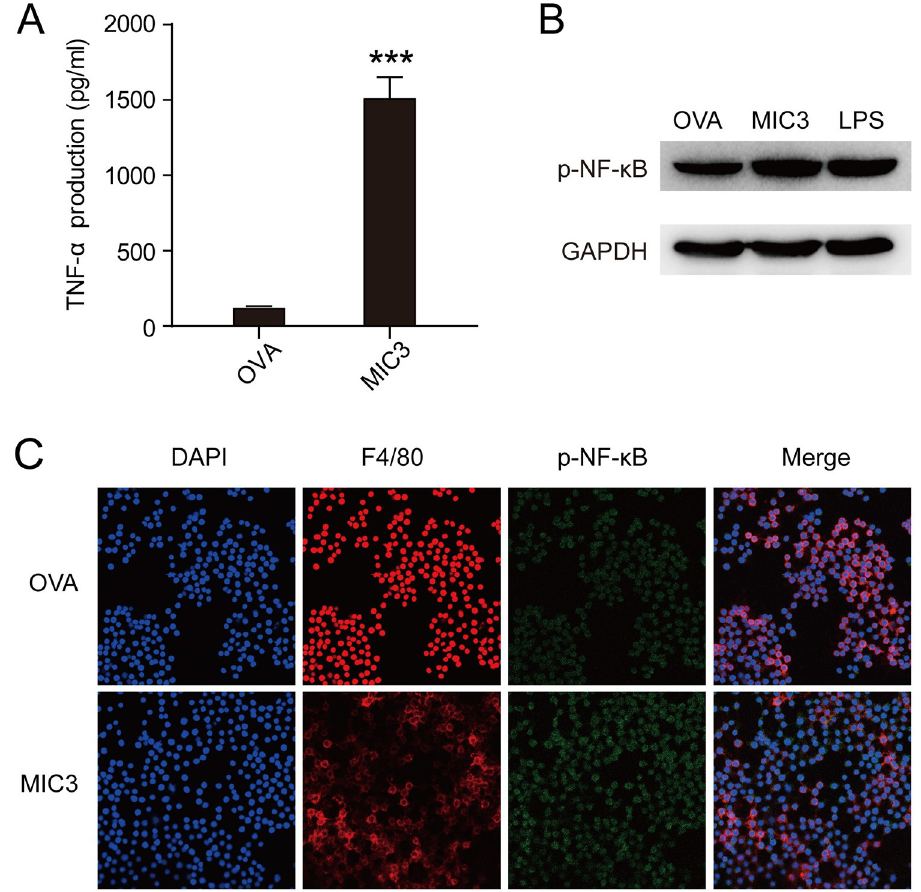
Fig 1. MIC3 induced TNF- α expression and NF- κ B p65 phosphorylation in RAW264.7 cells. (A) The levels of TNF- α secreted by RAW264.7 cells after 24 h-treatment of 4 μ g/ml MIC3 and OVA. Data are expressed as the means ± S.D. of four independent samples for each group. Significance was determined by the two-tailed Student’s t - test. ��� , P < 0.001. (B) NF- κ B p65 phosphorylation of macrophages after the treatment of MIC3. The NF- κ B p65 phosphorylation of RAW264.7 cells after 24 h-treatment of 4 μ g/ml MIC3, 4 μ g/ml OVA and 1 μ g/ml LPS was detected by Western blotting. (C) The NF- κ B p65 phosphorylation of RAW264.7 cells after 24 h-treatment of 4 μ g/ml MIC3 and 4 μ g/ml OVA was evaluated by immunofluorescence